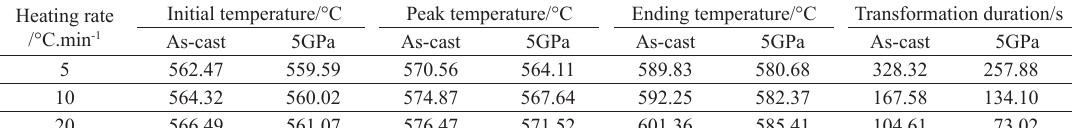
→ß in Cu-Al alloy before and after high pressure treatment under 2